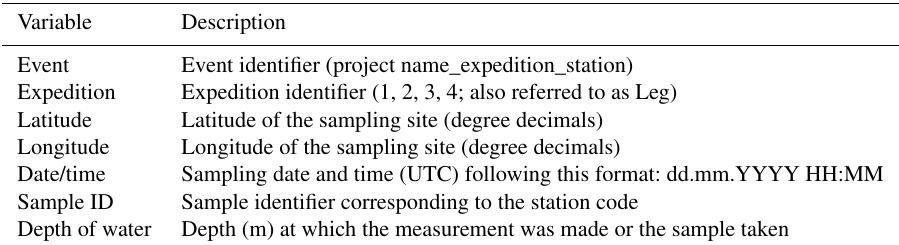
Table 1. Descriptions of the minimal variables included in each dataset.